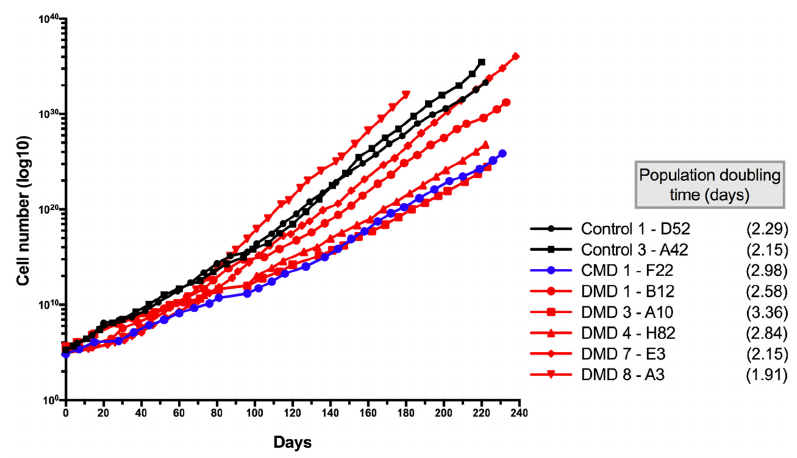
Figure 4. Long-term culture of iHMuSC clones. Eight clones from eight patients were cultured up to 240 days.